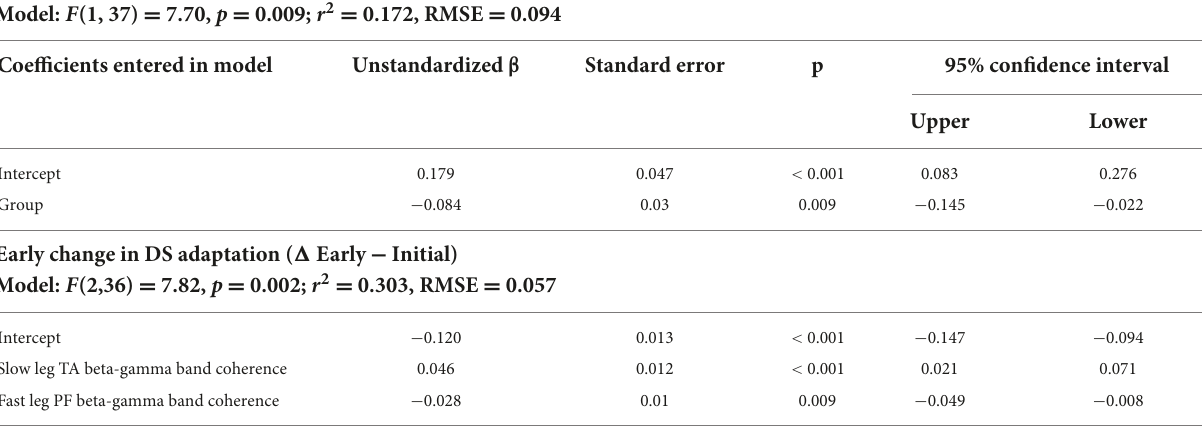
TABLE 6 Multiple linear regression